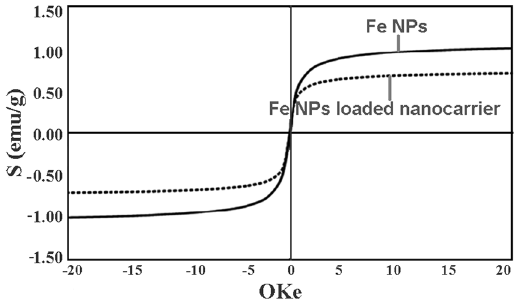
Figure 4. Magnetic properties of CPT-CEF determined through magnetometer.